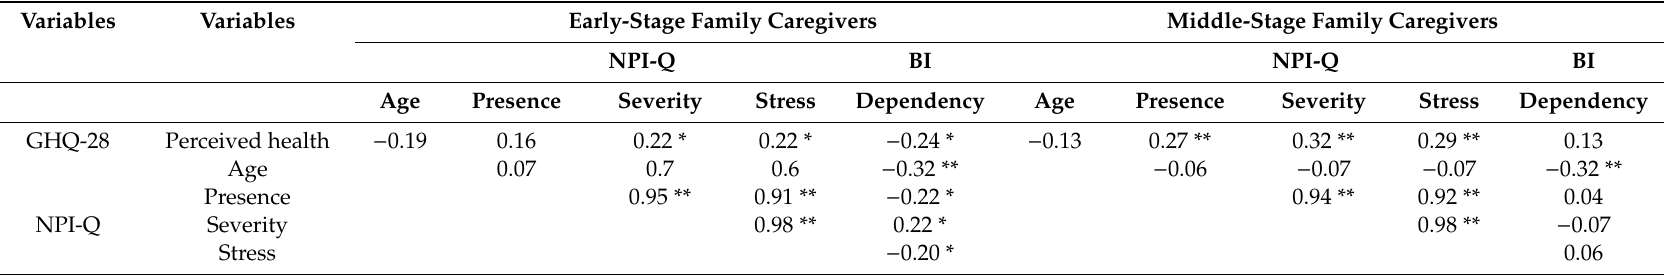
Table 4. Correlations between variables related to the patient and perceived health, depending on the stage of the